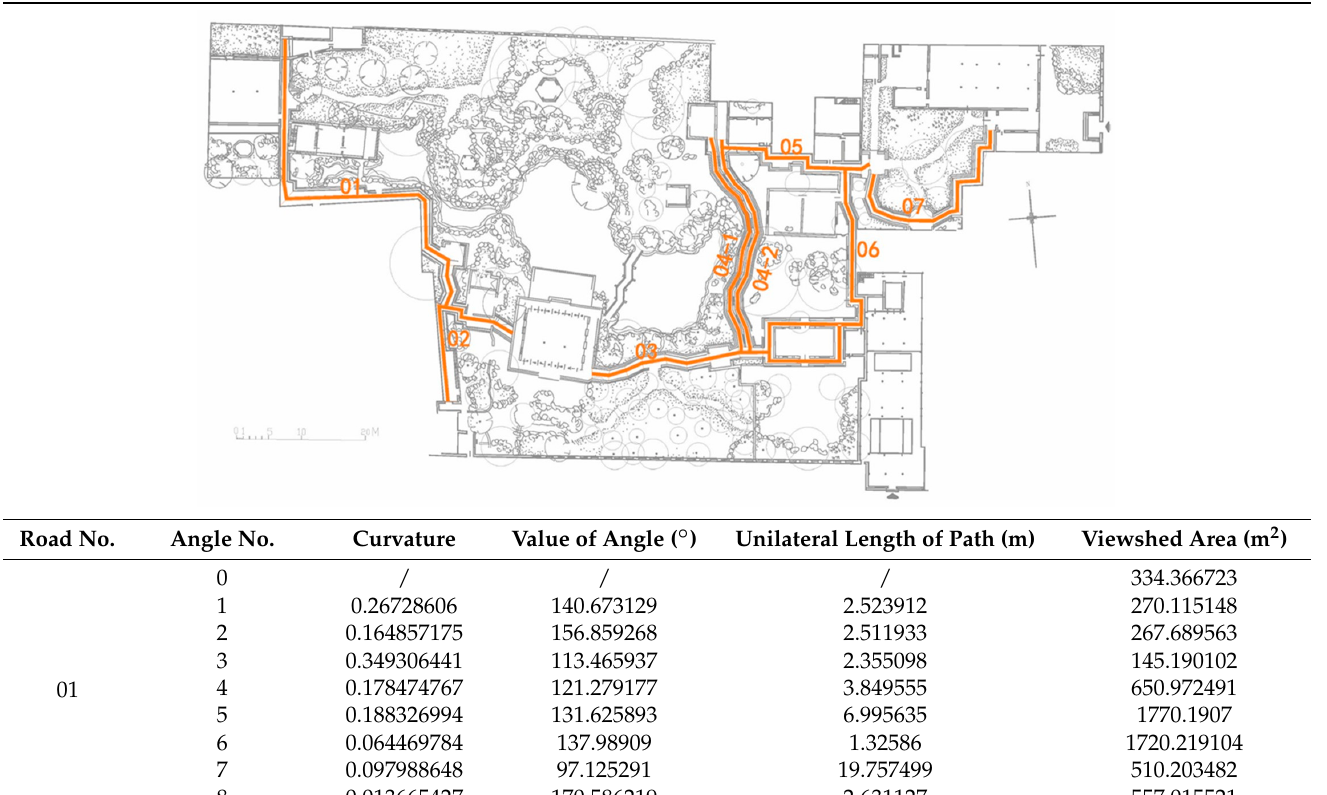
Table A15. Garden of Harmony, corridor.